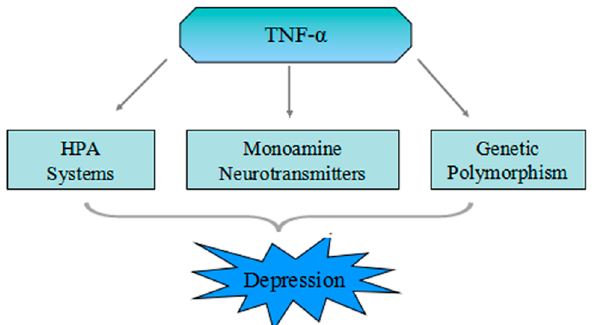
Figure 1. Scheme of the three different mechanisms which show correlation between tumor necrosis factor (TNF)- α and major depressive disorder (MDD). Peripheral TNF- α stimulated by infection and tissue damage cross the blood-brain barrier (BBB) through fast transmission pathway involving primary afferent nerves a slow transmission pathway or saturable transport system. Furthermore, single nucleotide polymorphisms in the promoter region of the TNF- α gene can induce high binding affinity of nuclear factors to the TNF promoter, which can elevate the level of transcription activity and secretion of TNF- α . TNF- α may cause depression or depressive symptoms through HPA-axis activation, neuronal serotonin transporter activation, and the motivation of the indoleamine 2,3-dioxygenase, which leads to tryptophan depletion.